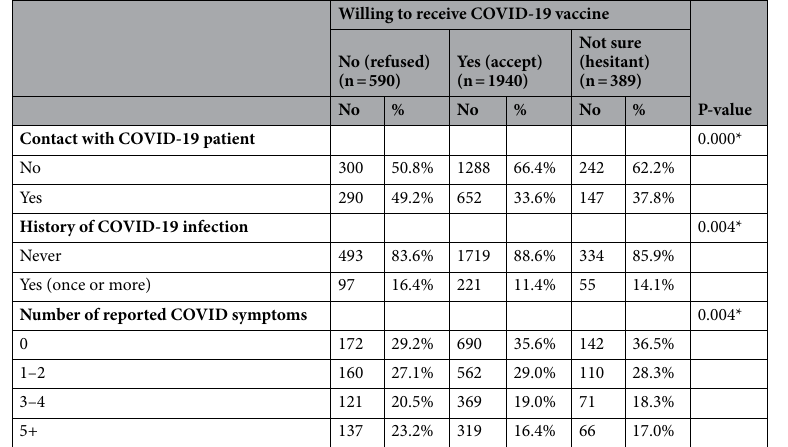
Table 2. Relation between vaccine acceptance and COVID-19 associated factors (n = 2919).